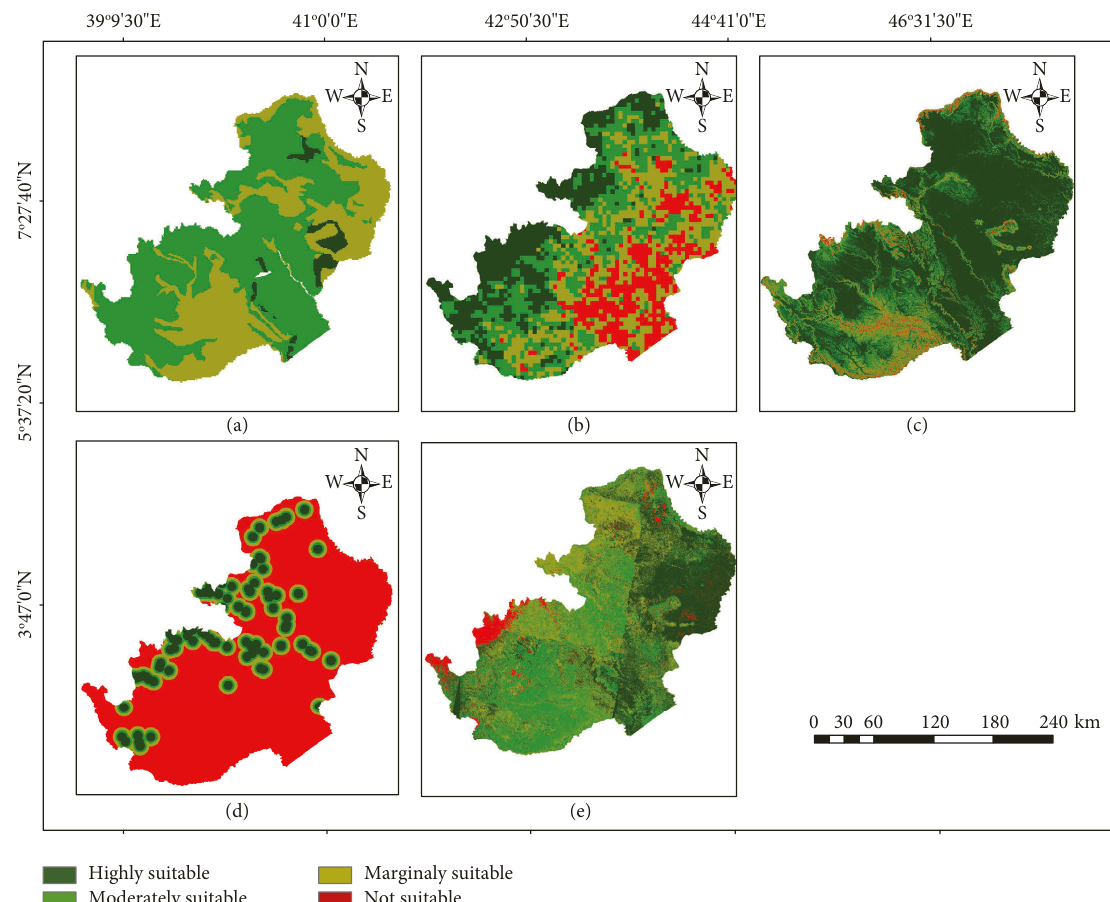
Figure 9: Factor suitability map for sheep mobility: (a) soil type, (b) rainfall, (c) slope, (d) water accessibility, and (e)